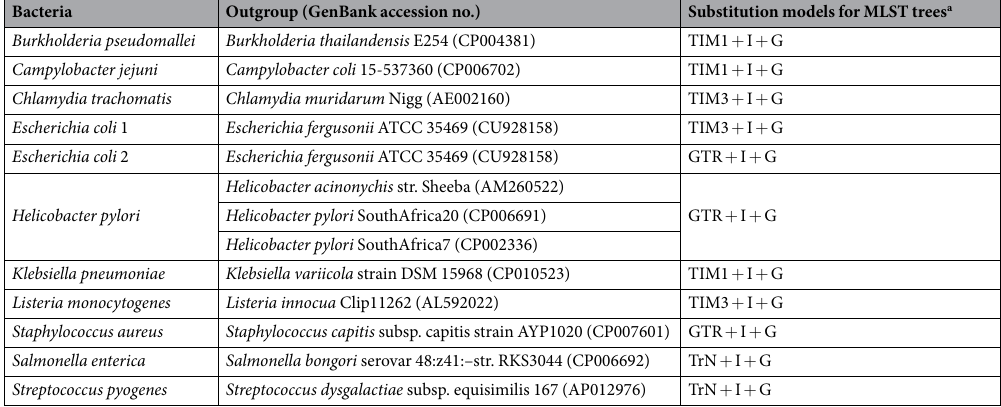
Table 1. Information of outgroups and models used to construct maximum likelihood phylogenetic trees for each bacterial species in this study. a G, gamma distributed rate of heterogeneity; I, proportion of invariant